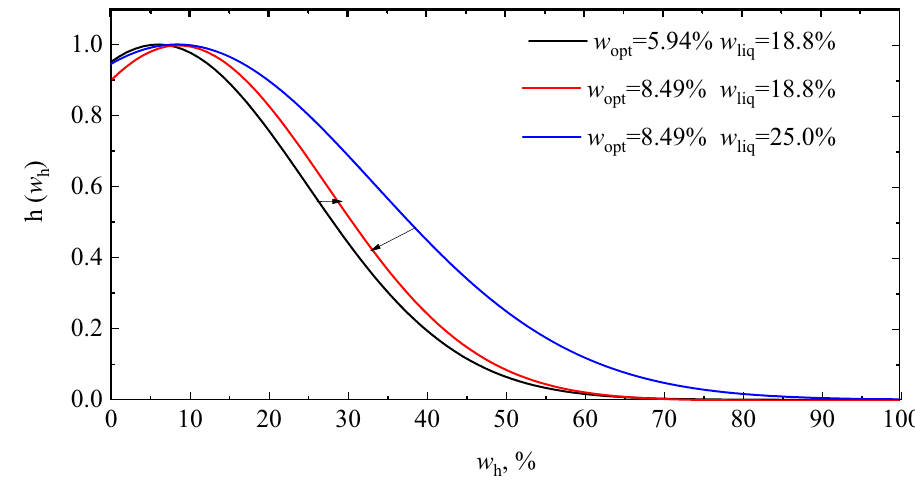
Figure 13. Moisture holding capacity correction function.